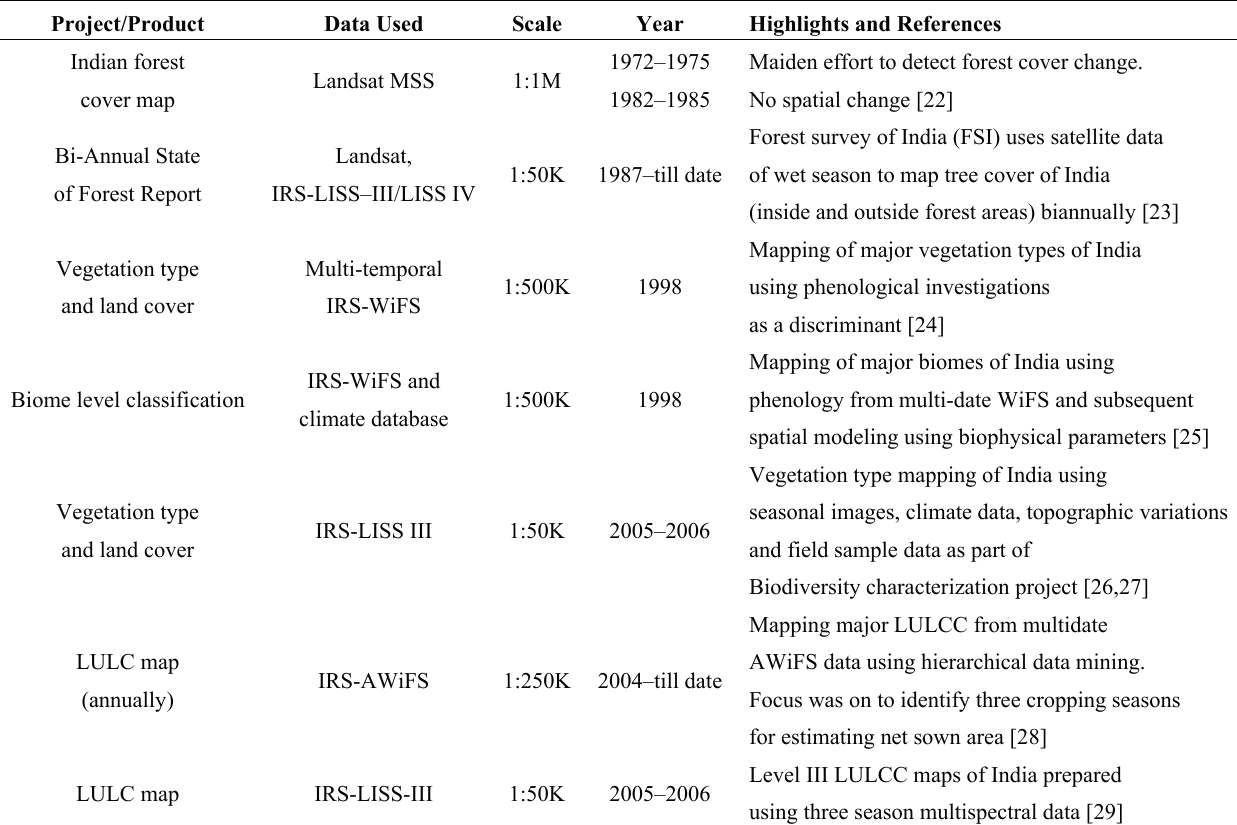
Table 1. LULC mapping initiatives in India using satellite remote